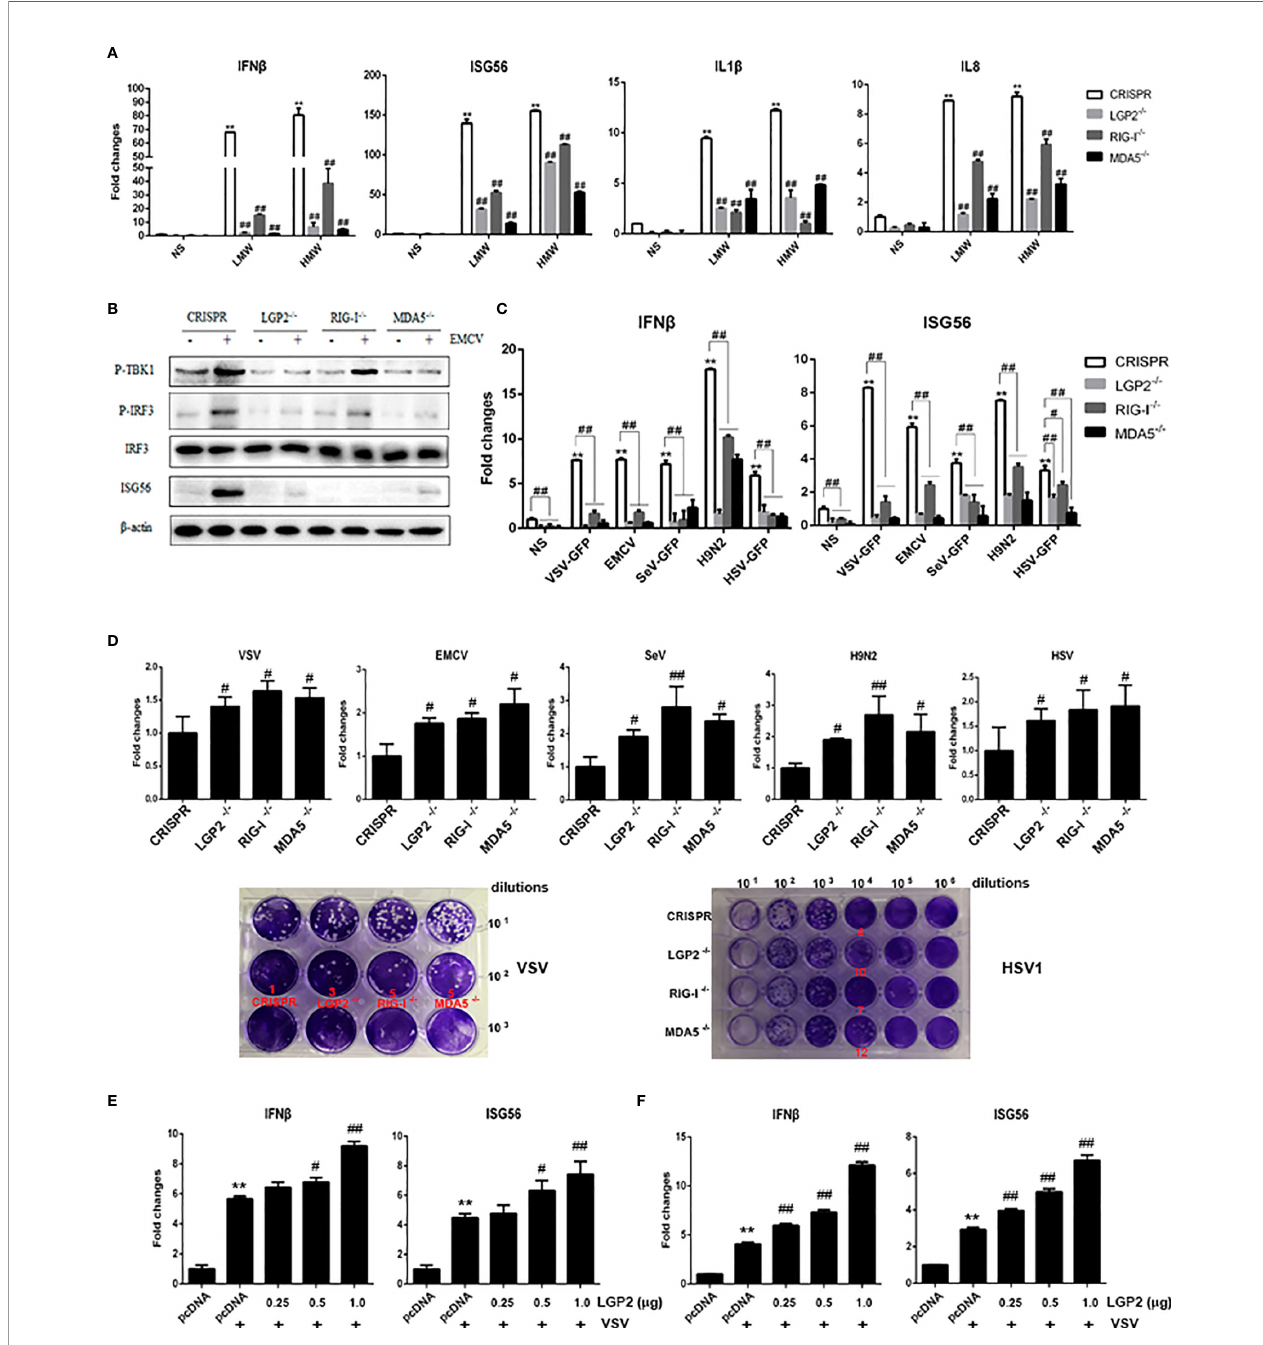
FIGURE 5 | Expressions of cellular genes and viral replications in LGP2, RIG-I and MDA5 homozygous KO PAM cell clones. (A) The LGP2 -/- , RIG-I -/- and MDA5 -/- PAMs plus CRISPR control PAMs grown in 12-well plates (5×10 5 cells/well) were transfected with LMW poly I:C or HMW poly I:C (1 m g/ml) for 8h. The expression of downstream cellular genes were analyzed by RT-qPCR. (B) The LGP2 -/- , RIG-I -/- and MDA5 -/- PAMs plus CRISPR control PAMs grown in 12-well plates (5×10 5 cells/well) were infected with EMCV at 0.01 MOI for 8 h. The cells were detected by Western-blotting with the indicated antibodies. (C, D) The LGP2 -/- , RIG-I -/- and MDA5 -/- PAMs plus CRISPR control PAMs in 12-well plates (5×10 5 cells/well) were infected with various viruses at MOI of 0.01 for 8-12 h and analyzed by RT-qPCR for the expressions of downstream cellular genes (C) and viral genes (up panel, D ). The supernatants from VSV and HSV1 infected PAMs were subjected to infection of Vero cells and the viral plaques were visualized at 30 h and 72 h post infection, respectively. The countable plaque numbers are labeled in red color below the wells of cell plates (low panel, D ). (E, F) MDA5 -/- PAMs (E) and RIG-I -/- PAMs (F) in 24-well plates were transfected different amounts of LGP2 and stimulated with 0.01 MOI VSV for 8 h. The downstream IFN b and ISG56 were analyzed by RT-qPCR. ** p < 0.01 vs NS controls. # p < 0.05, ## p < 0.01 vs CRISPR controls in (A – D) , or pcDNA VSV controls in (E, F)